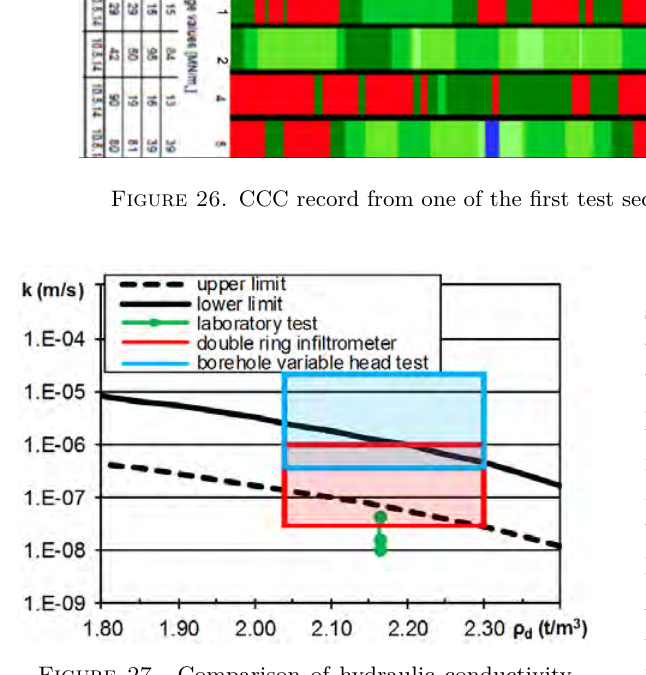
Figure 27. Comparison of hydraulic conductivity predicted after Kozeny-Carman equation (upper limit, lower limit) and measured values in laboratory and on